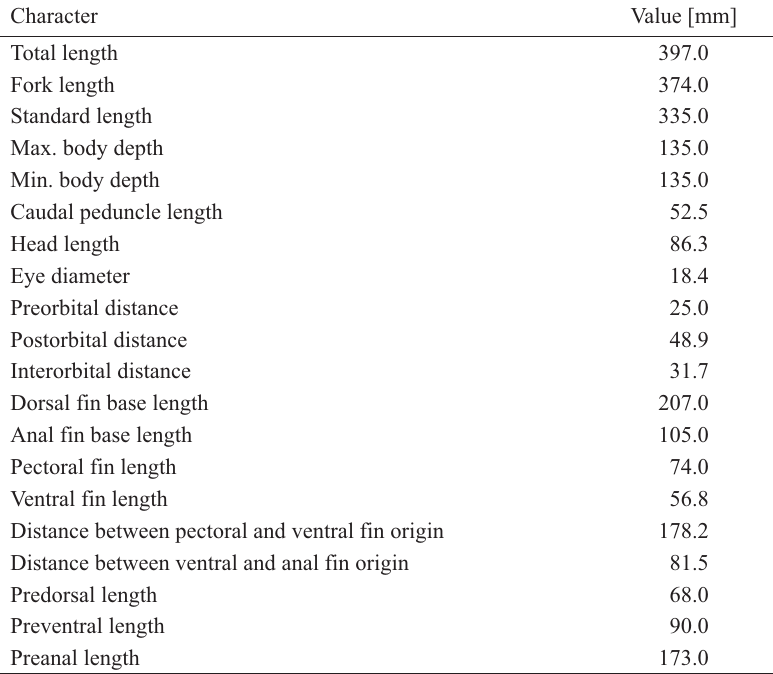
Morphometric characters of the Schedophilus ovalis specimen from the Aegean